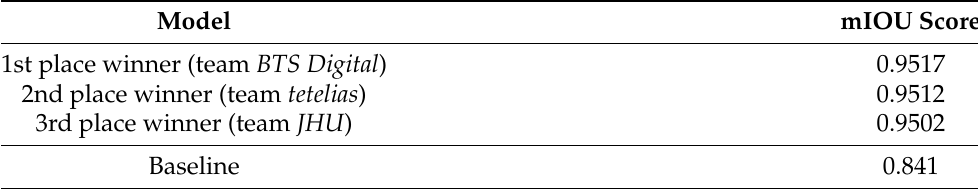
Table 7. Performance (mIOU) from the top-3 winning entries to the OpenEDS 2020 Sparse Semantic Segmentation